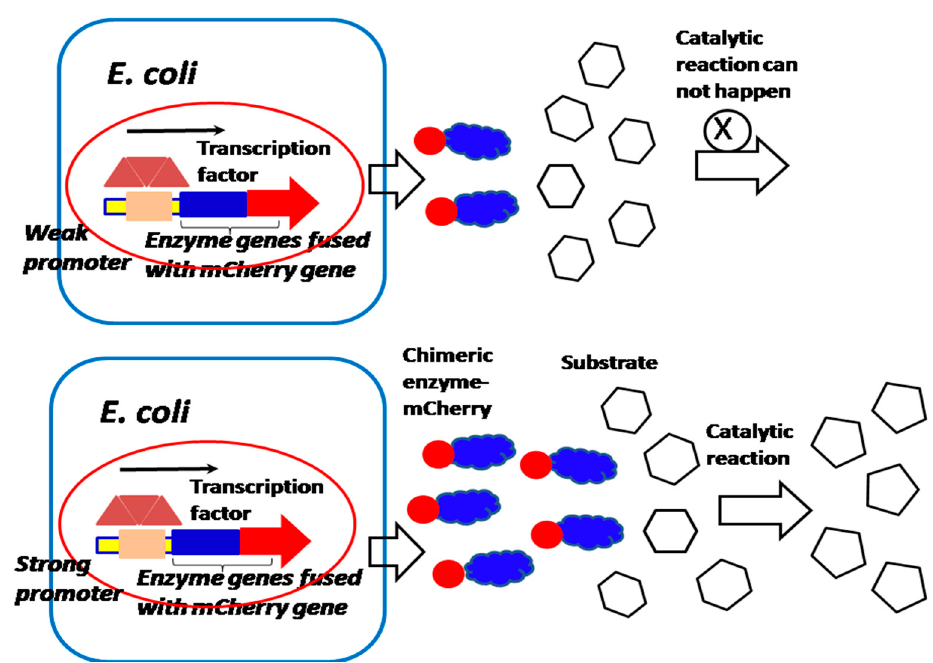
Figure 7. A performance-enhanced promoter is applied for studying the enzyme activity. High concentration of the enzyme will produce high catalytical activity, if the enzyme is not saturated by a substrate.